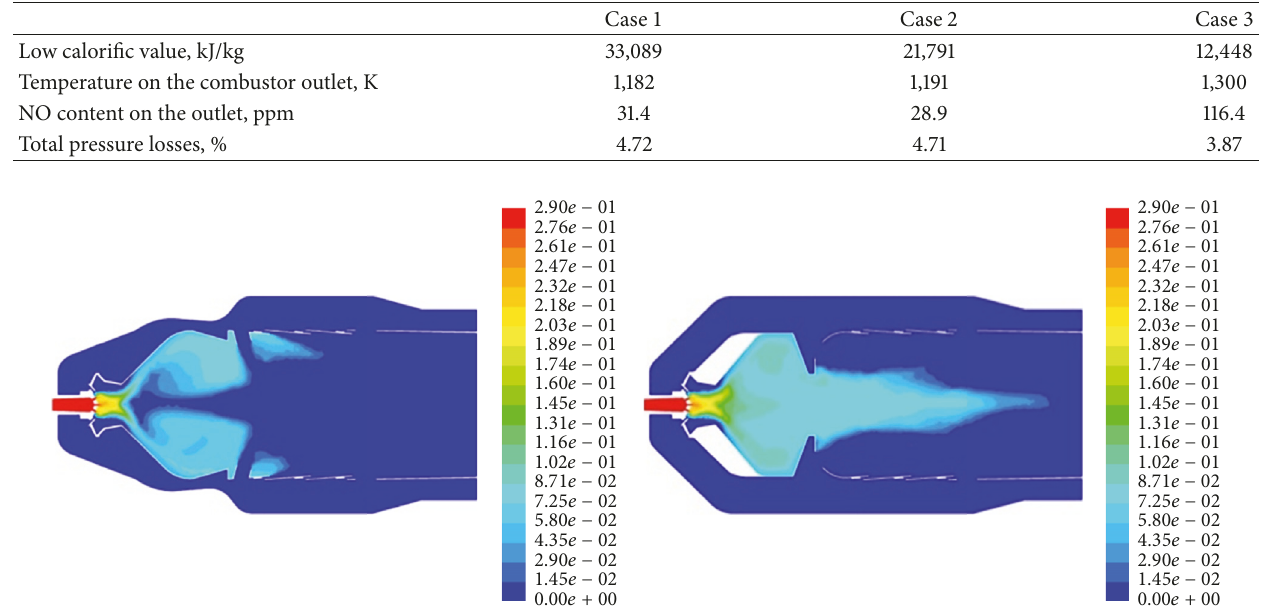
flows which leads to worsening of the combustor ecological